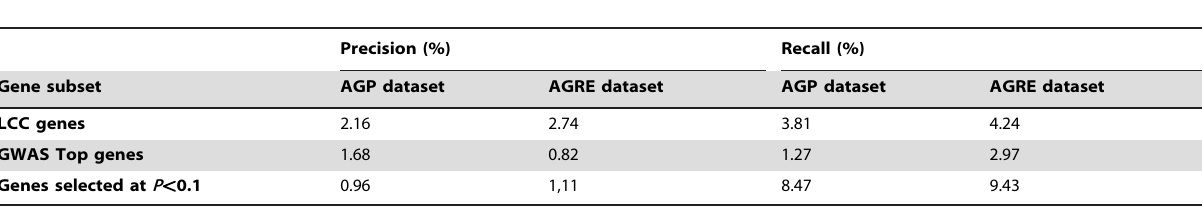
Table 1. Precision and recall were consistently higher for LCC genes relative to top GWAS genes or genes selected at P , 0.1.